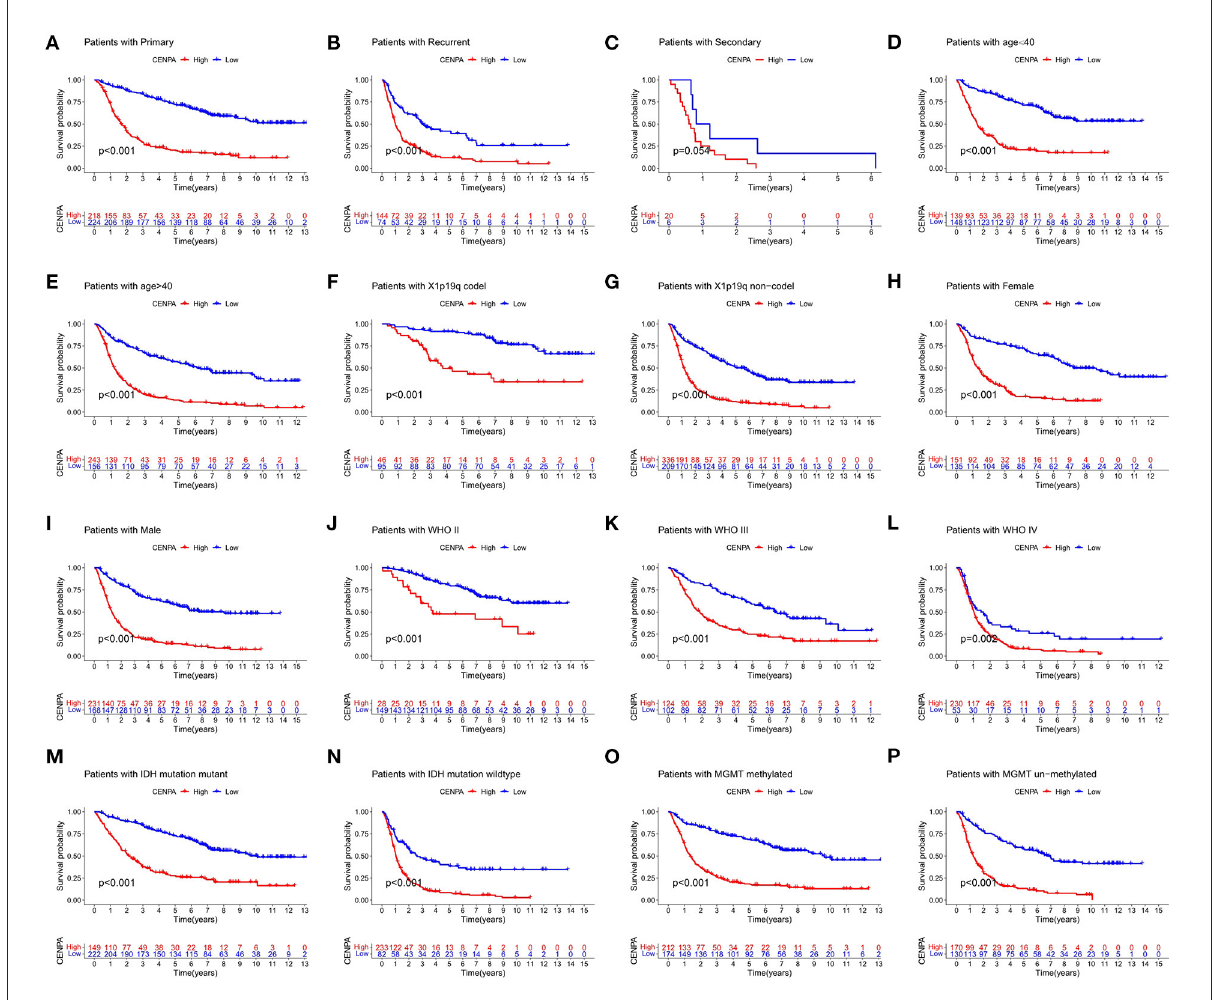
FIGURE5 CENPA remains prognostic in different subgroups of patients with glioma, including (A–C) PRS type, (D,E) age, (F,G) 1p19q status, (H,I) sex, (J–L) WHO grade, (M,N) IDH status, and (O,P) MGMT status.